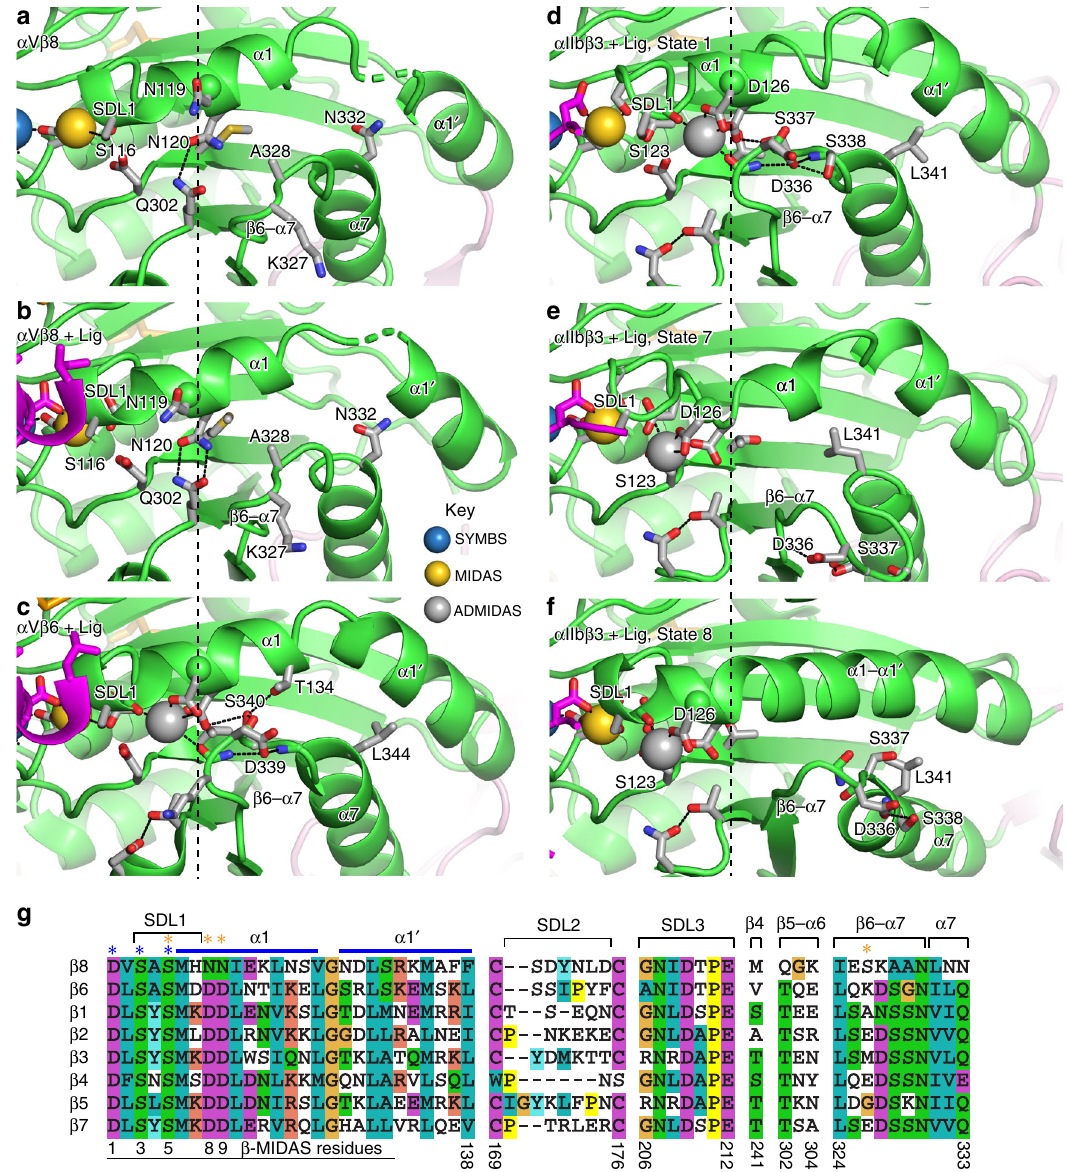
Fig. 3 Residues important in β I domain allostery. a – f The mobile portion of the β I domain is shown in a unliganded α V β 8, chain D; b liganded α V β 8, chain B; c liganded α V β 6 (4UM9, chain B); d liganded α IIb β 3 in state 1 (3ZDY, chain D); e liganded α IIb β 3 in state 7 (3ZDZ, chain B); and f liganded α IIb β 3 in state 8 (2VDR, chain B). Structure representation is as in Fig. 2, except that sidechain carbons are in silver and mainchain carbons are in green. Vertical dashed lines mark the position of the β -MIDAS motif D8 C α atom in α IIb β 3 state 1 ( d ). g Sequences of all human integrin β I domains in regions that are important in ligand binding, shape shifting, or appear to have unusual residues in β 8. Residues with sidechain or mainchain coordination to the MIDAS or ADMIDAS in typical integrins are asterisked in blue and orange, respectively. β -MIDAS residue positions and β 8-subunit residue numbers are shown at the ligand of the S5 and N8 residues and the α 1-helix in which they locate to positions that are intermediate between closed and open (Figs. 3 and 4). Eight states along the conformational change pathway, including closed state 1, open state 8, and intermediate states 2 – 7, have been captured in α IIb β 3 crystal structures 21 . α IIb β 3 states 1, 7, and 8 are shown in Fig. 3d – f for comparison to α V β 8. Throughout the shape-shifting process, the α 1-helix, with SDL1 at its tip (Fig. 3g), moves toward the ligand and tightens its binding pocket at the MIDAS. The ADMIDAS Ca 2 + ion moves with its coordinating D8 and D9 residues in the α 1-helix. The position of the β -MIDAS D8 residue or N8 residue in β 8 is marked with a C α -sphere in Fig. 3a – f. For comparison among superimposed β I domains, the vertical dashed lines in